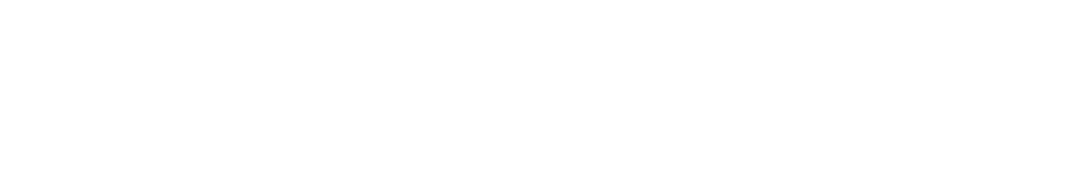
Note. The numbers refer to the number of trainees commenting on each theme.